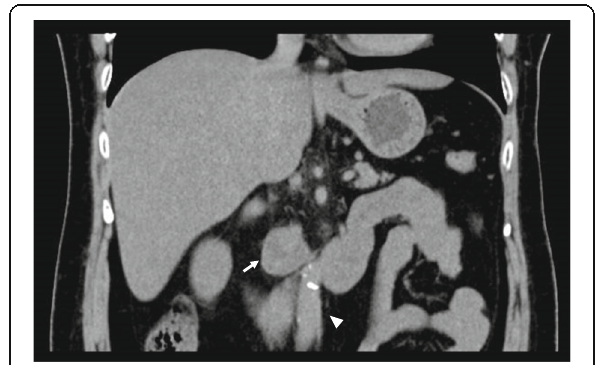
Fig. 1 Coronal noncontrast computed tomography image. A heterogeneous mass in the right retroperitoneal region (white arrow) adjunct to the inferior vena cava (white arrow head) is